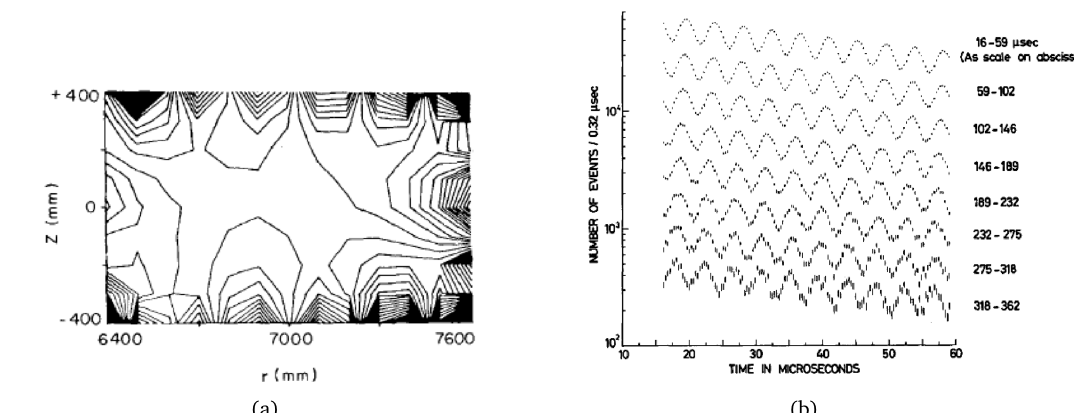
Figure 7: (a) The magnetic field averaged over azimuth from the CERN-3 experiment. The contours are 2 ppm (3 µ T). The periodic structure of the contours most likely came from the width of the grinding wheel used in the shimming. (From Ref. [ 43 ] ). (b)The arrival time spectrum from a portion of the CERN-3 data. (From Ref. [ 45 ]